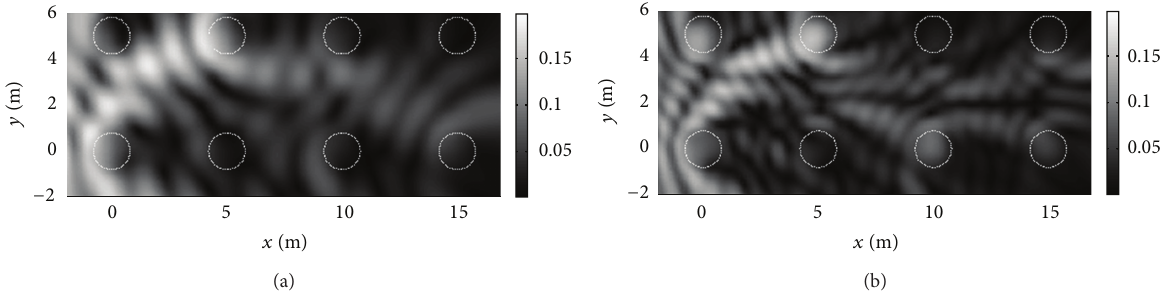
Figure 10: 3D plots of the sound field for frequencies of (a) 600 Hz and (b) 1000Hz.